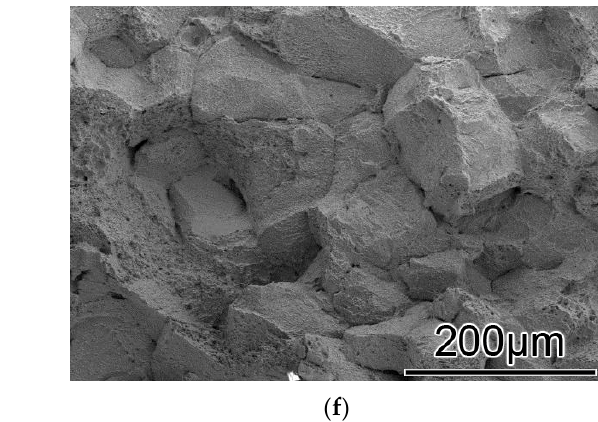
Figure 6. Fracture analysis of the specimen after impact test: ( a ) origin, ( b ) 50 h, ( c ) 100 h, ( d ) 200 h, ( e ) 300 h, and ( f ) 500 h.